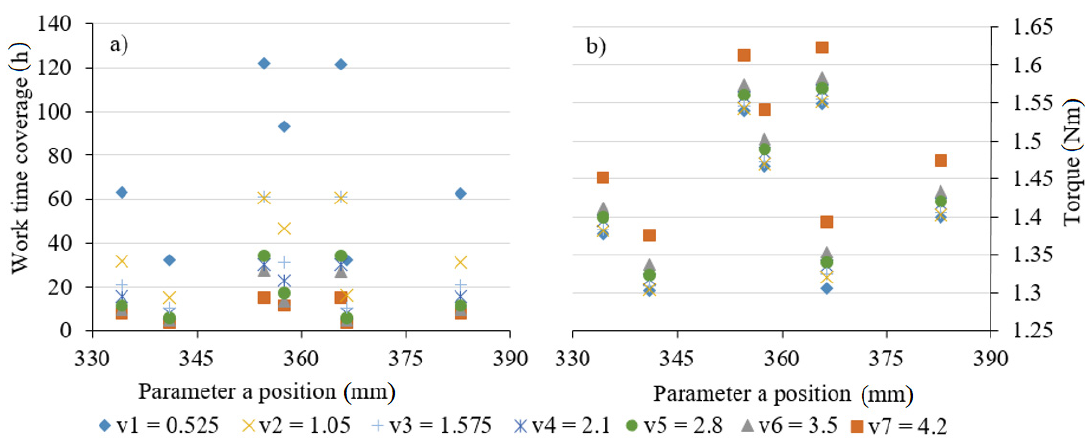
Figure 10. Demand for driving torque as a function of parameter 𝑎 value and system weight.